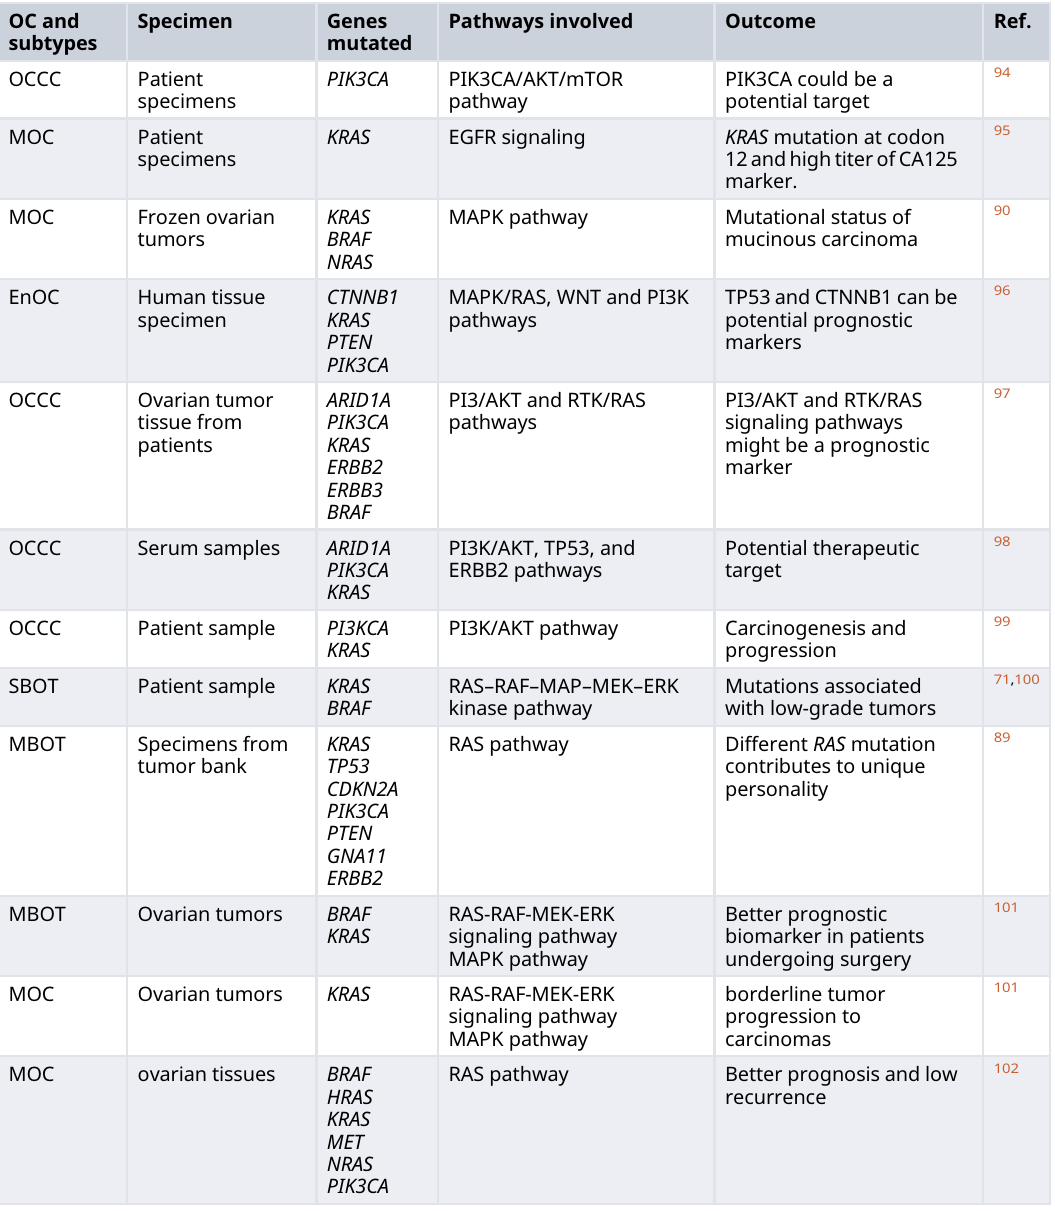
Table 2. Mutational status and clinical relevance of RAS mutations in OC. OC and